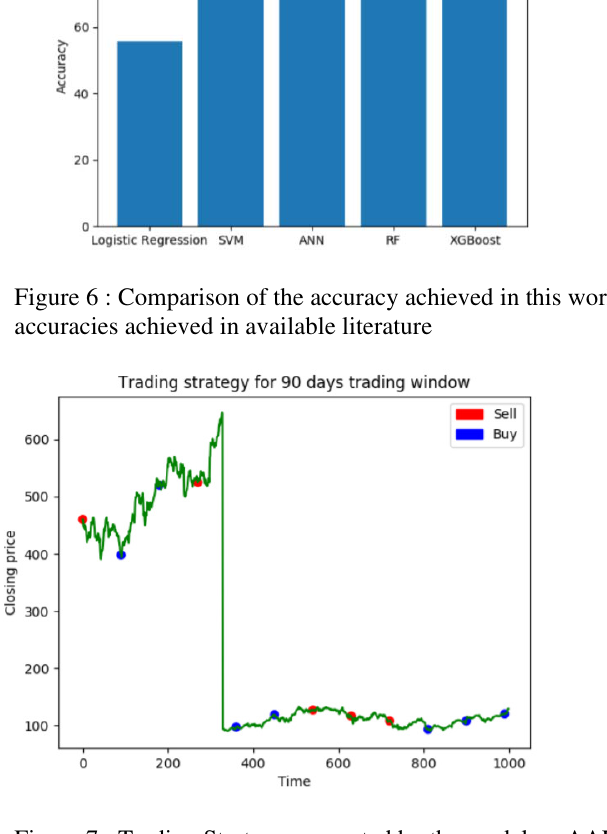
Figure 7 : Trading Strategy suggested by the model on AAPL data